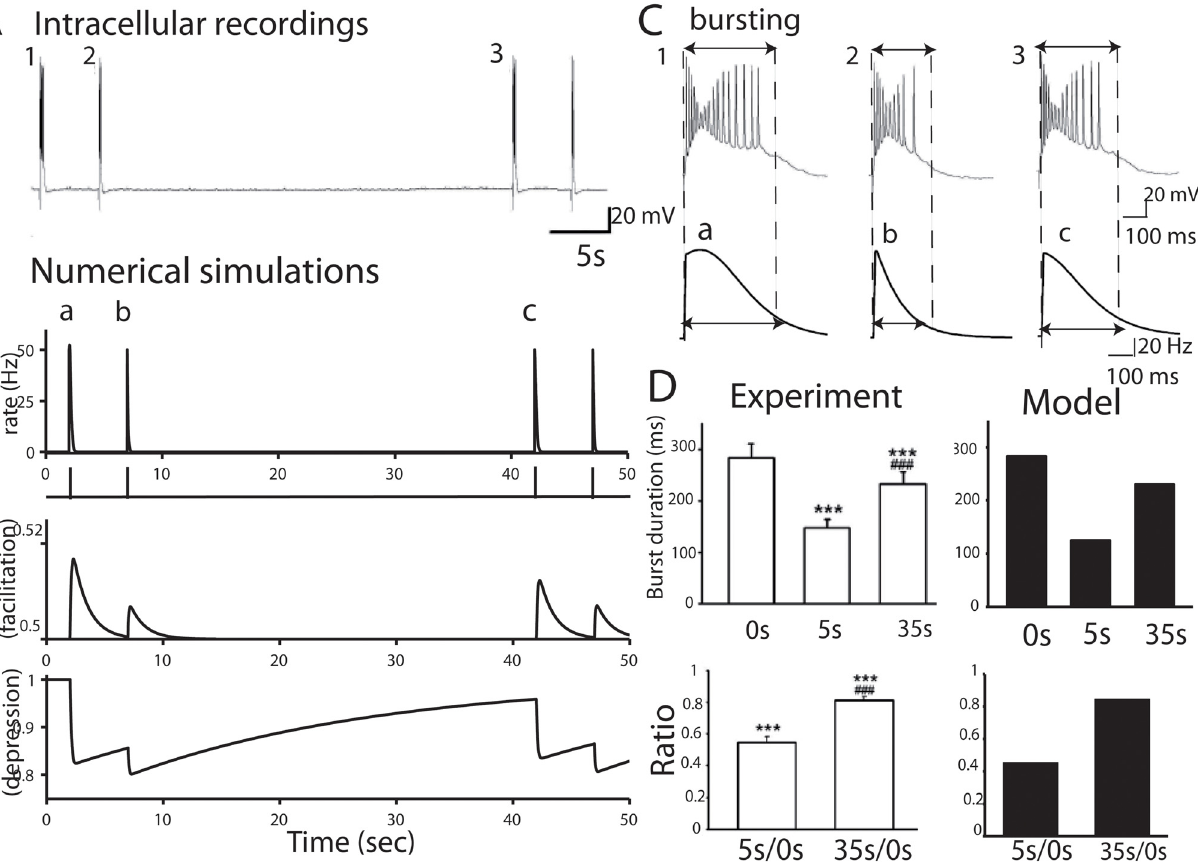
Fig 5. Reduction of burst duration in hippocampal slices and facilitation-depression synaptic model. (A) Bursts (1,2 and 3) in pyramidal cells from hippocampal acute slice evoked by a single stimulation of Schaffer collaterals alternately at 5 and 35 seconds intervals, showing a reduction in burst duration when the bursts are generated in shorter intervals. (B) Following the experimental protocol, we simulated the mean firing rate response (Eq 1), and generating bursts at similar time intervals (a, b and c) as in the intracellular recordings. The facilitation and depression variables show the level of neuronal activity underlying the overall dynamics. (C) Magnification of the evoked bursts (from A1, 2 and 3) and the simulated response (B a, b and c). (D) (Up) Comparison between experimental data and numerical simulations of bursting durations at the initial stimulation time, 5 and 35 s intervals. (Down) Burst duration ratios of the 2nd and 3rd to the initial burst (experimental data and numerical